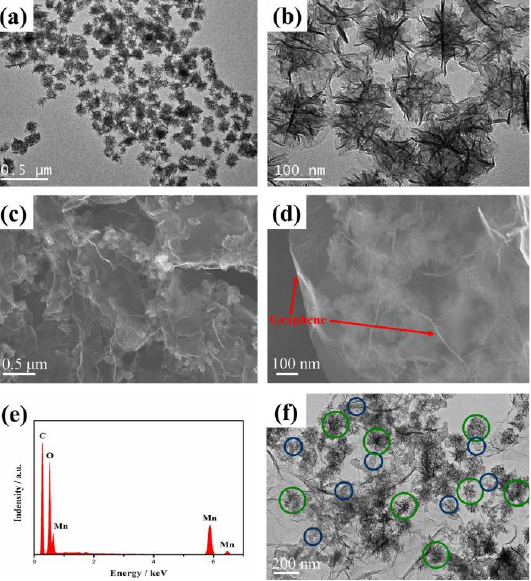
Figure 7. ( a , b ) TEM images of honeycomb MnO 2 nanospheres; ( c , d ) FE-SEM images of MnO 2 /C/G composites; ( e ) EDX spectrum of MnO 2 /C/G composites; ( f ) TEM image of MnO 2 /C/G composites. Reproduced by permission from [76]. Copyright © 2015, Elsevier B.V.